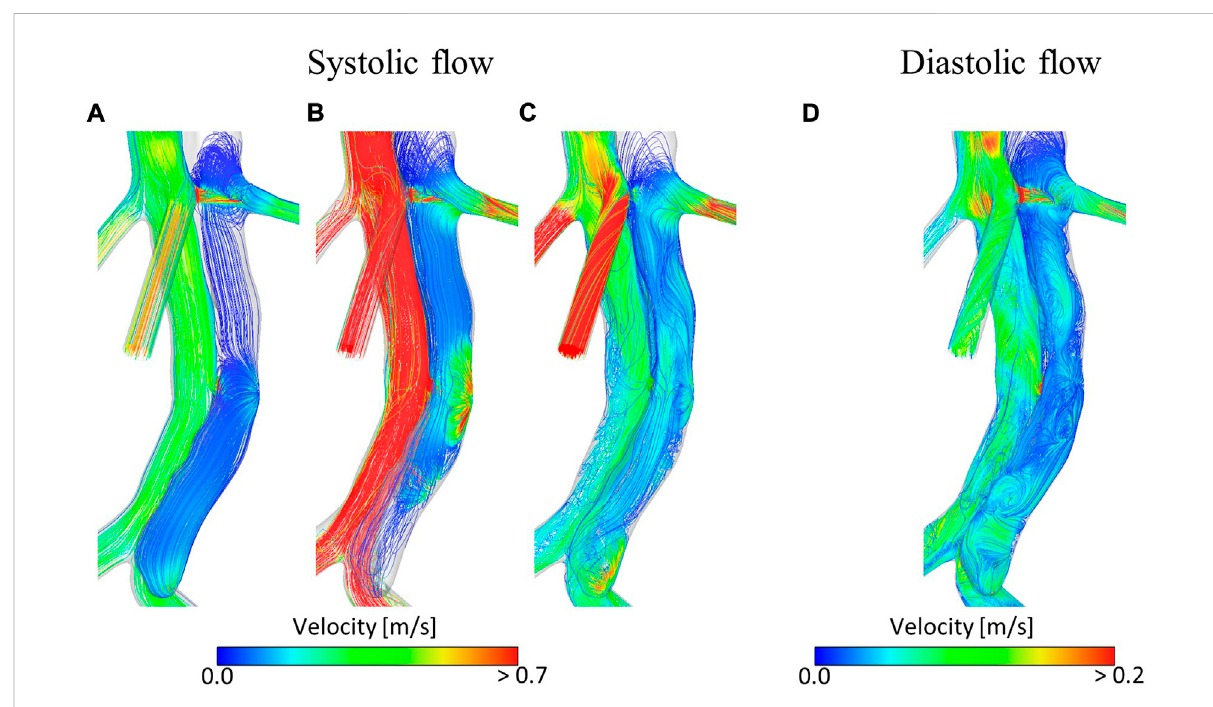
FIGURE 4 Velocity streamlines at (A) mid-systolic acceleration, (B) peaksystole, (C) mid-systolic deceleration, (D) earlydiastoleduring thesecondcardiac cycle of the